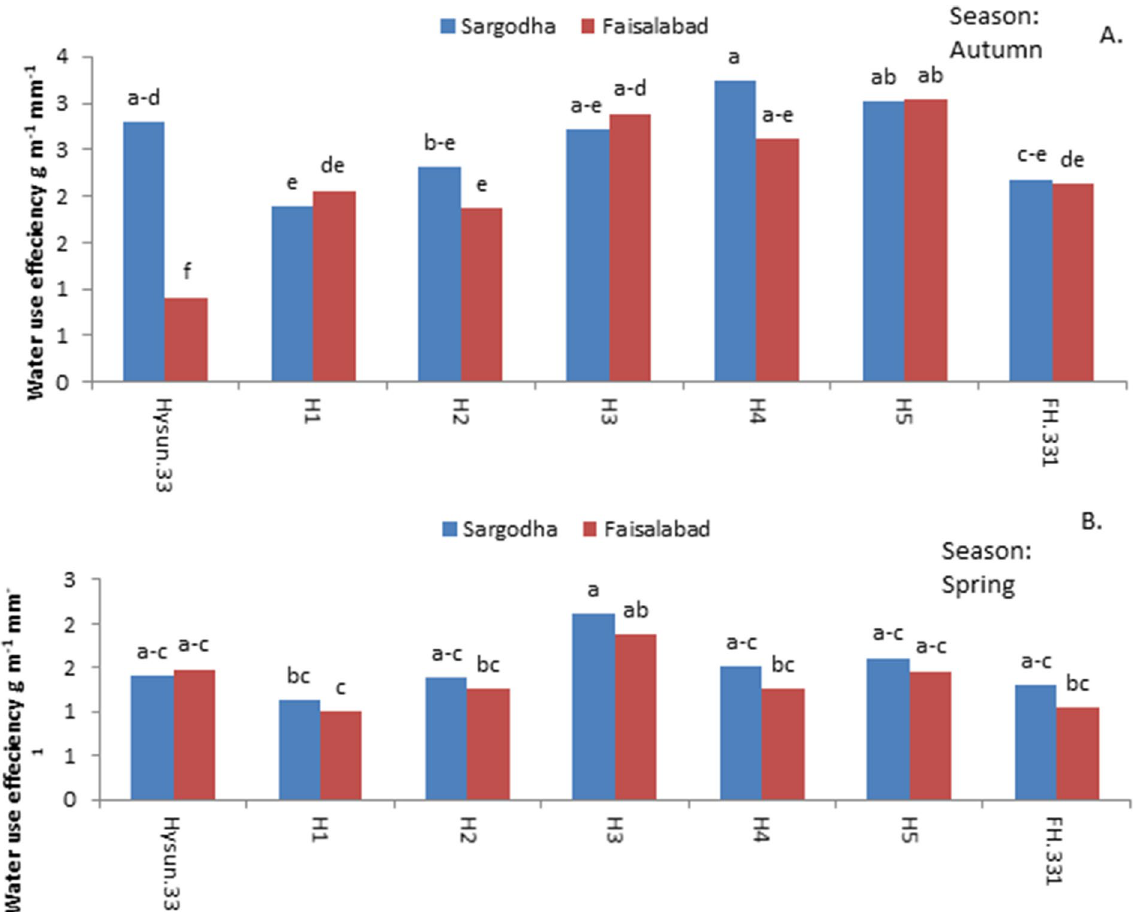
Figure 7. Water use efficiency (g mm −1 ) of sunflower hybrids varied for drought and heat tolerance during ( A ) Autumn and ( B ) Spring